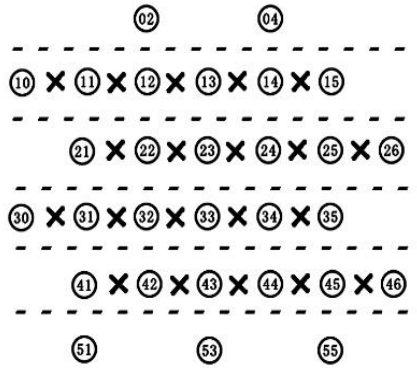
Figure 1. Arrangement of 3D six-directional braiding yarn.